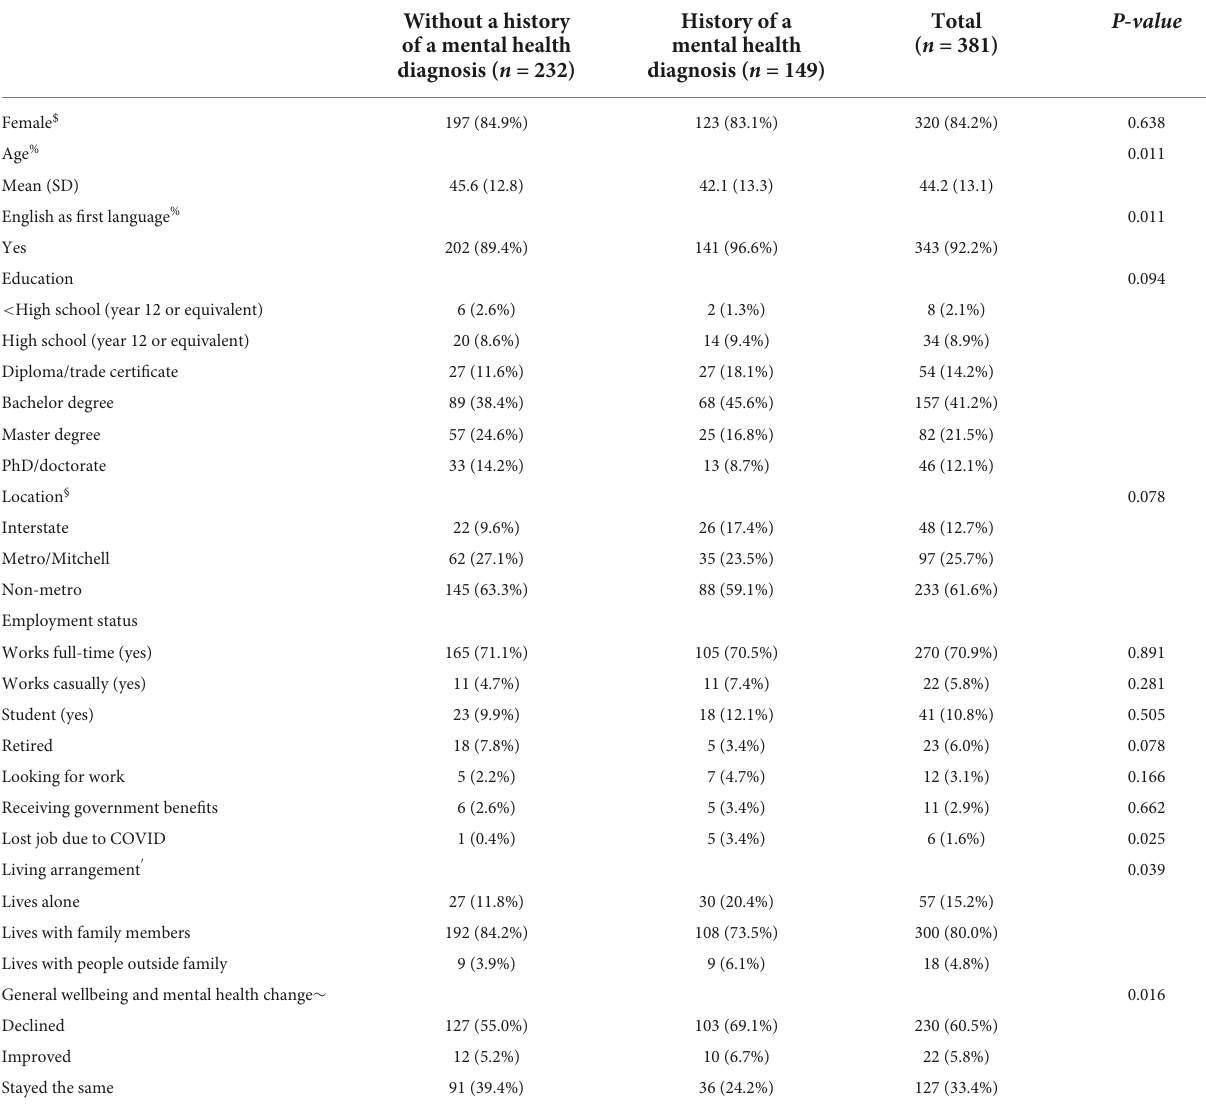
TABLE 1 Characteristics of participants by their history of diagnosis for mental